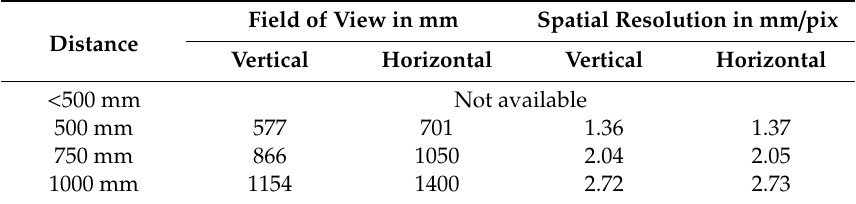
Table 1. Field of view and spatial resolution at different working distances for top view [44]. Distance